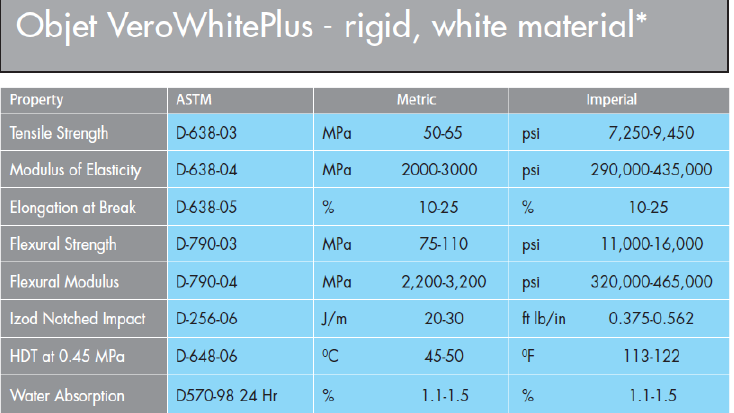
Figure A7. VeroWhitePlus material sheet from Stratasys. (Source: http://www.stratasys.com.cn/industries/education/research/4d%20printing%20project).